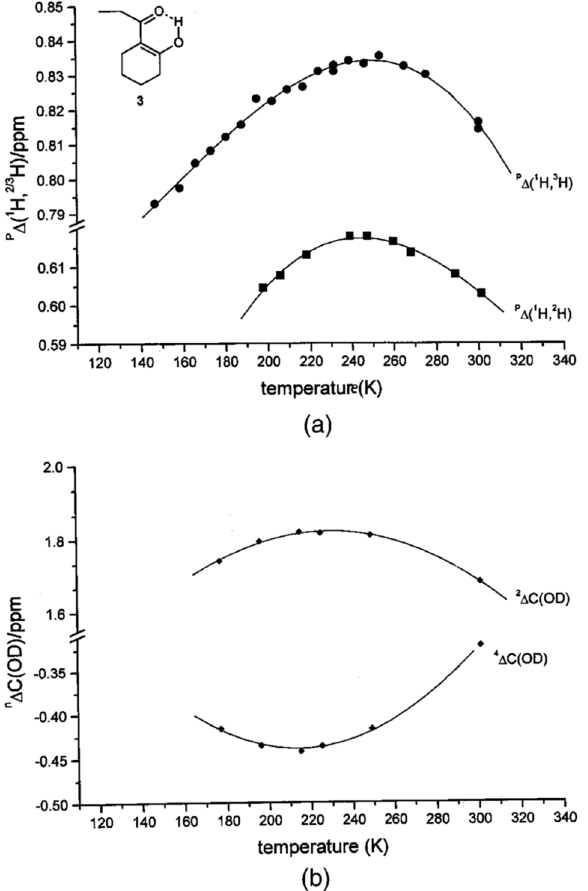
Figure 17. Top: Primary tritium, deuterium isotope effects. Bottom: Deuterium isotope effects on 13 C chemical shifts. Taken from Ref. [98] with permission from John Wiley and